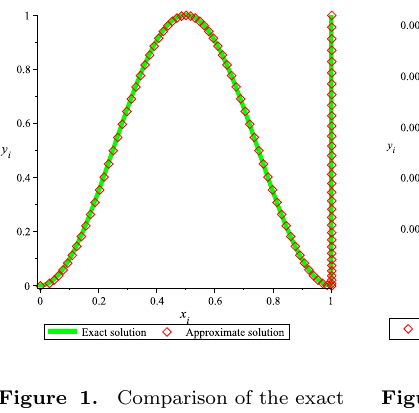
Figure 2. Error distribution of test problem for N = 128, ε = 2 − 15 , ε = 2 − 17 , ε = 2 − 19 , ε = 2 − 21